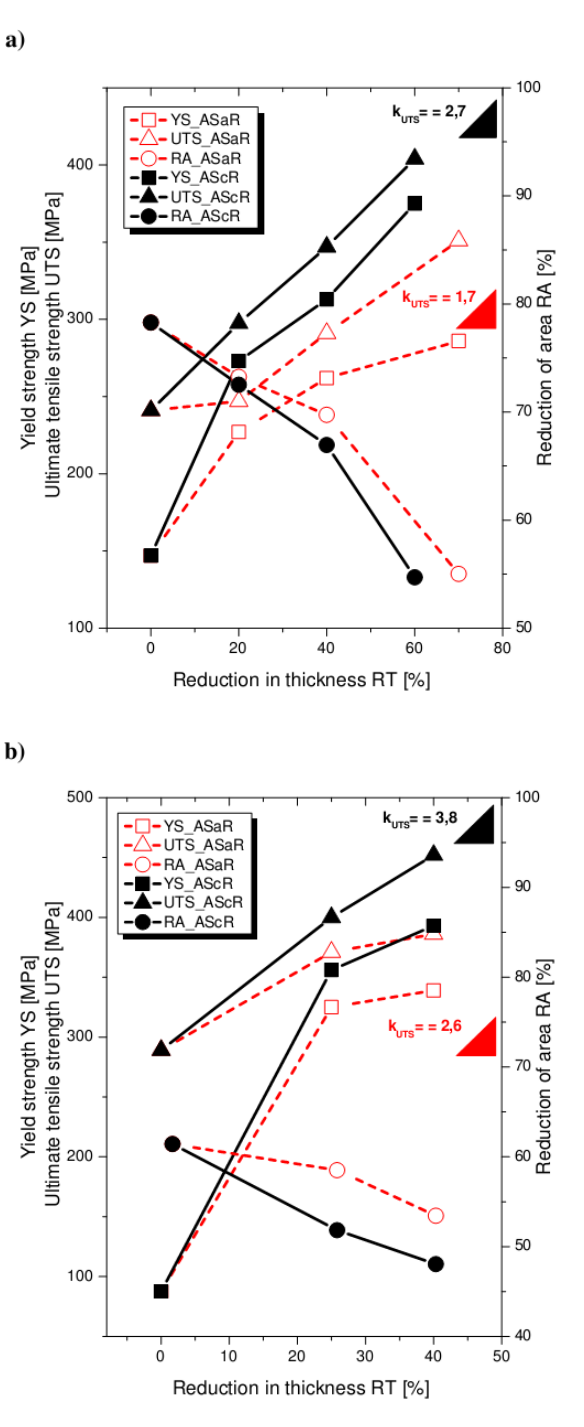
Figure 1: Mechanical properties after ASaR and AScR: a) Cu, b) Cu- CrZr